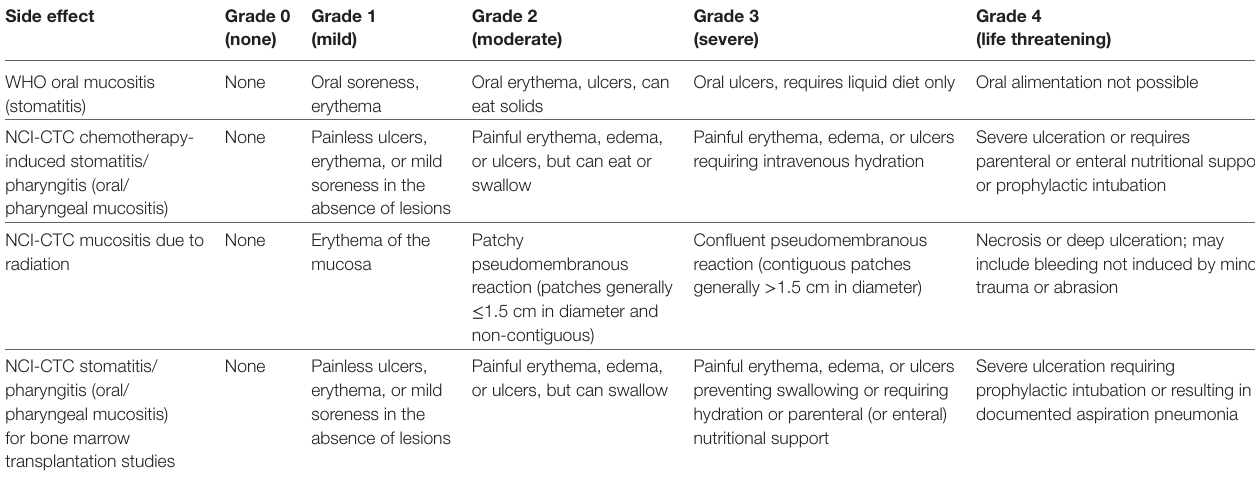
TAbLe 5 | Toxicity grading of oral mucositis (OM) according to world Health Organization (wHO) and National Cancer institute Common Toxicity Criteria (NCi-CTC) criteria (2) a